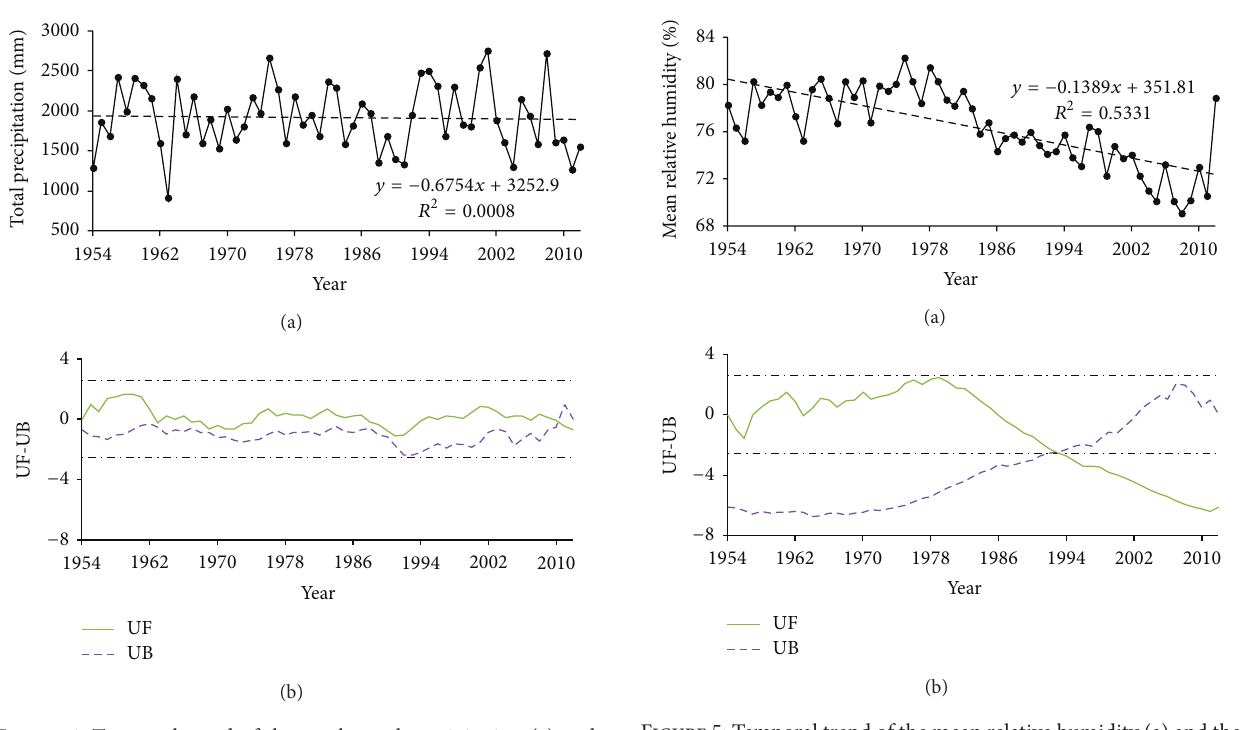
Figure 4: Temporal trend of the yearly total precipitation (a) and the trend results from the Mann-Kendall method (b).